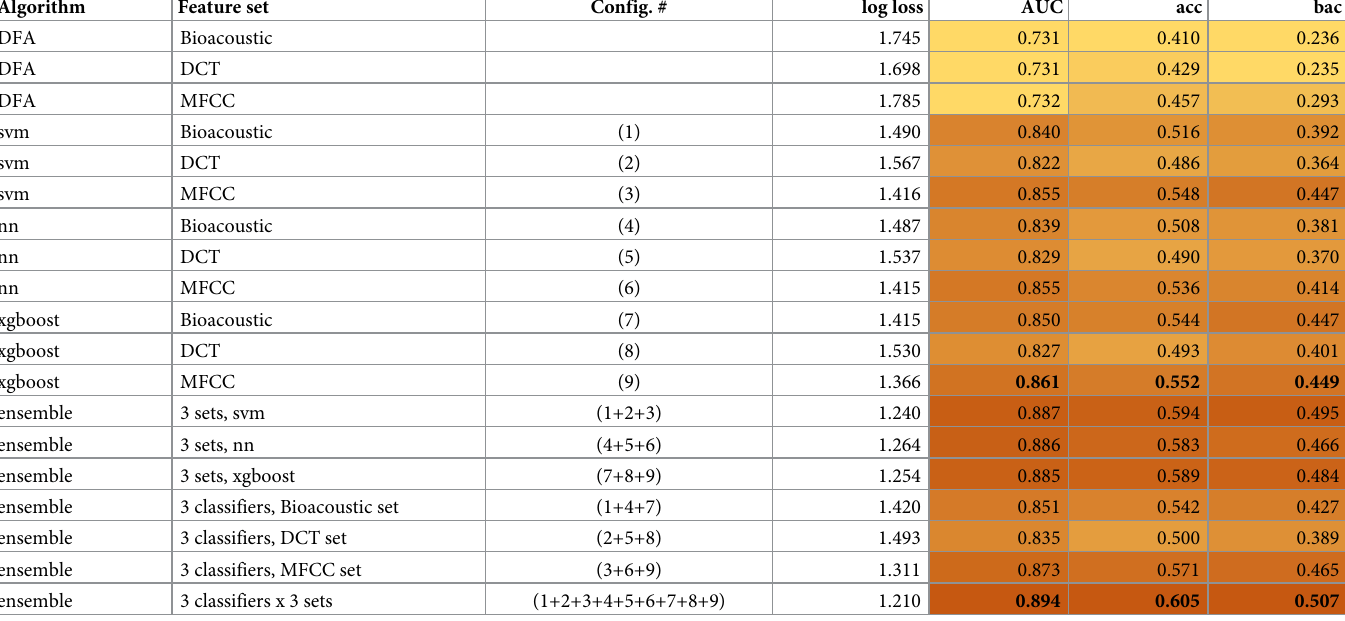
Table 3. Metrics characterizing the classification performance of individual signatures as a function of the classifier and acoustic set used. Four metrics are reported: log loss, AUC, balanced accuracy, and accuracy. The best performance achieved by a primary configuration (upper part) and an ensemble configuration (lower part) is dis- played in bold. For AUC, accuracy (acc) and balanced accuracy (bac), a color scale highlights the progression from the lowest scores (in pale orange) to the highest scores (in dark orange) in the